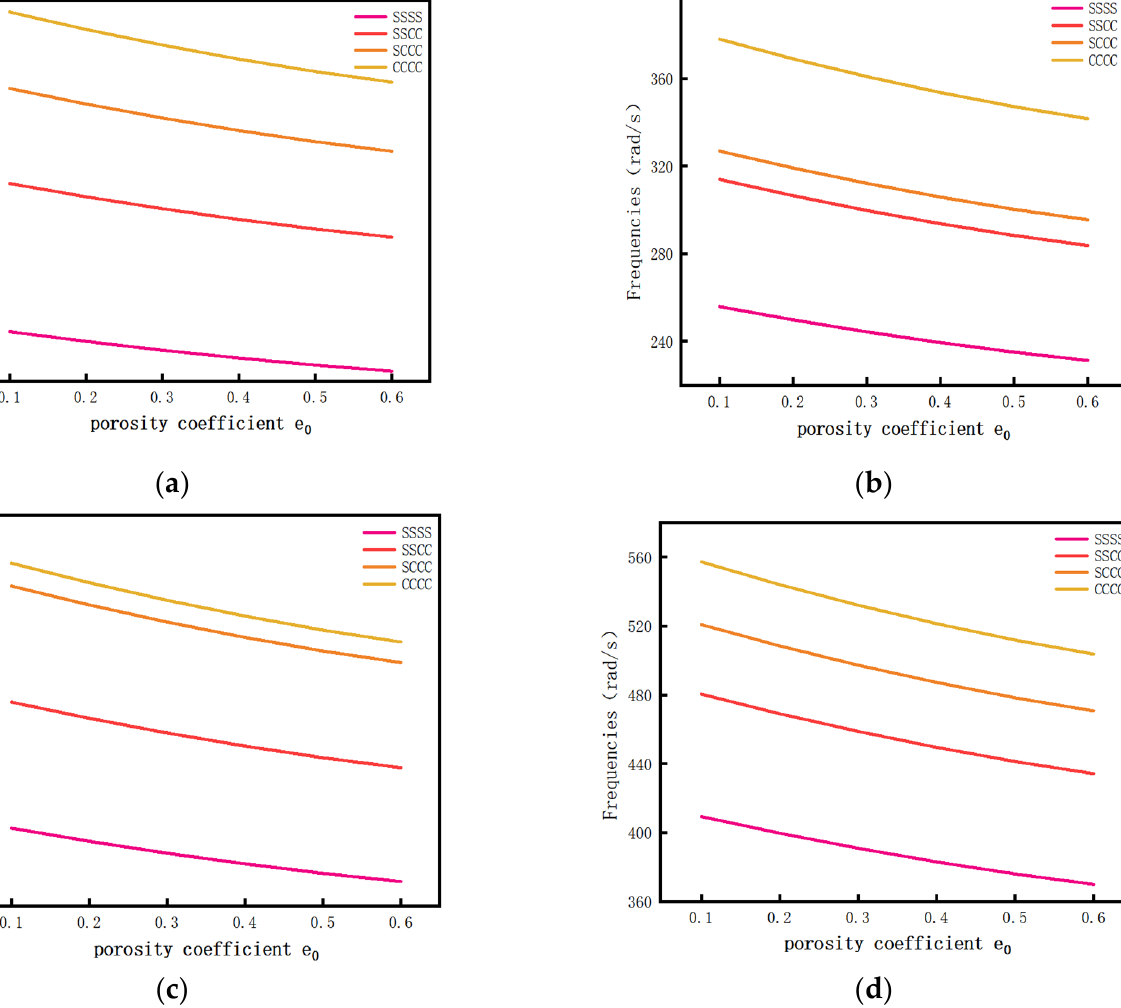
Figure 6. The relationship curve between the porosity coefficient and free vibration frequency. ( a ) First order vibration mode, ( b ) second order vibration mode, ( c ) third order vibration mode, and ( d ) fourth order vibration